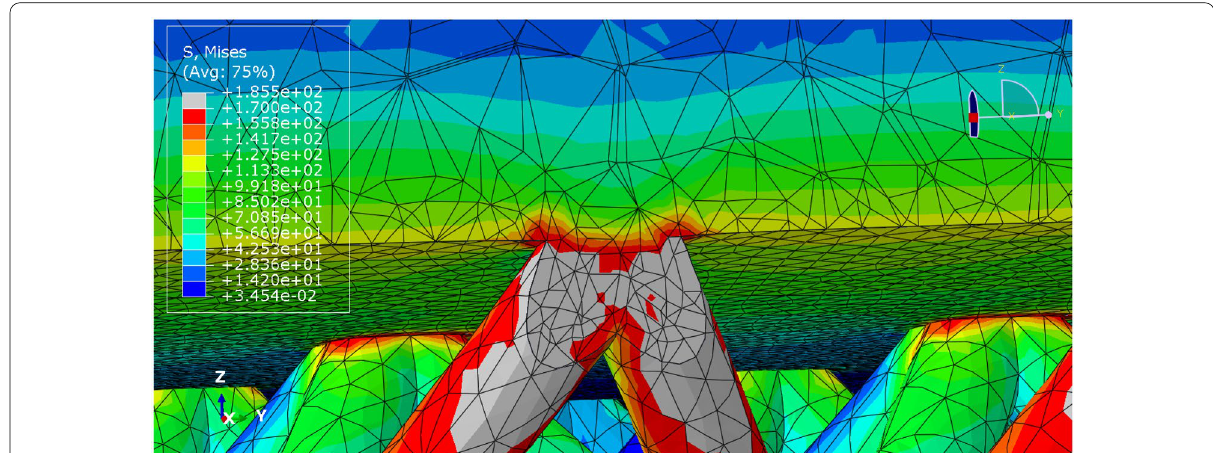
Figure 22 Section view of the model with thick faces at the middle joint of the outer row of cells. Zones with plastic deformation are marked